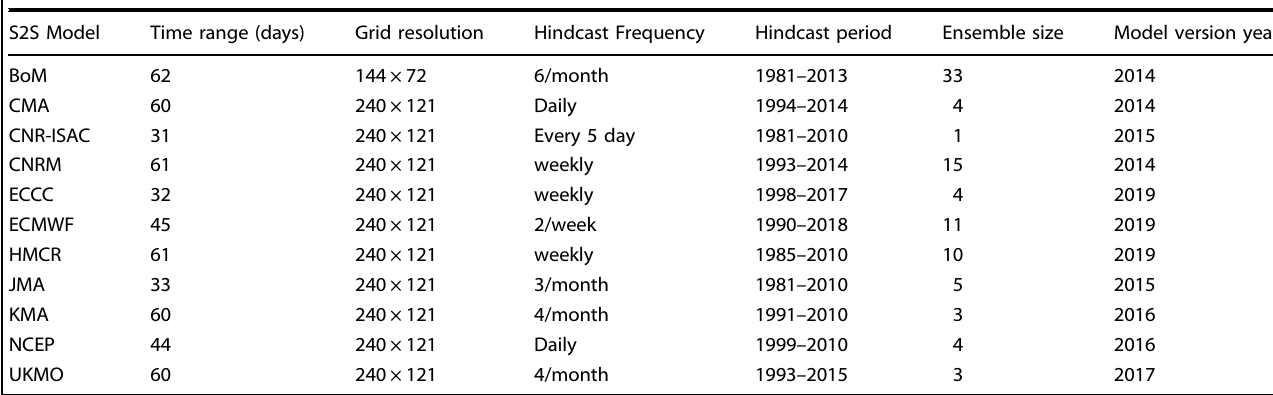
Fig. 7 Trends in the ISV intensities of individual summer monsoons during 1979 – 2018. The red bars show the trends (units in percentage change) of the ISV intensity averaged over the wet regions of the leading ISV modes (precipitation anomalies above 0.05 mm day − 1 in Fig. 3a) for a 8 – 20-day ISV and b 20 – 70-day ISV. The blue bars show the corresponding trends in the area-averaged seasonal-mean precipitation. The ISV intensity is de fi ned by the local-summer standard deviation of fi ltered precipitation anomaly. Signi fi cant trends at the 90% con fi dence level based on the Mann – Kendall rank statistics are marked by red circles. Table 3. Main features of the 11 contributions to the S2S